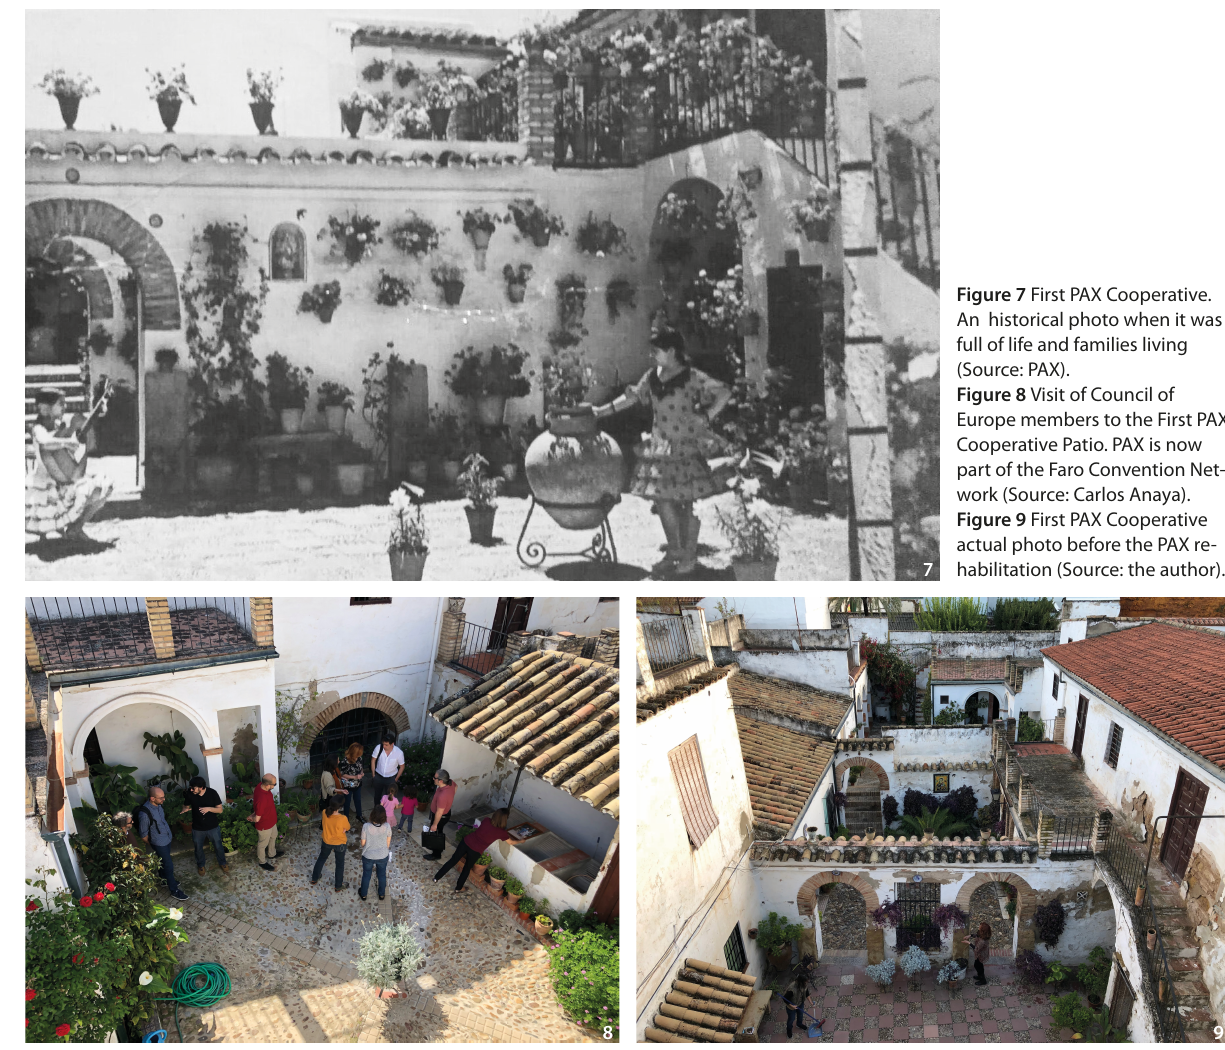
Figure 8 Visit of Council of Europe members to the First PAX Cooperative Patio. PAX is